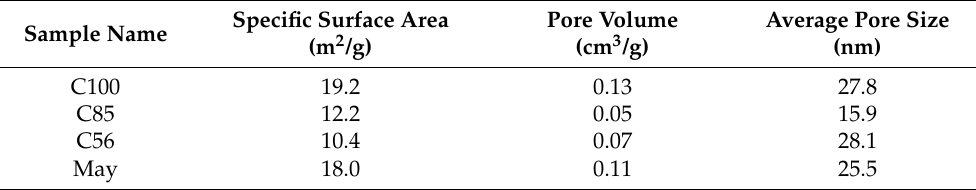
Table 4. Specific surface area, pore volume and average pore size of various sorbents.